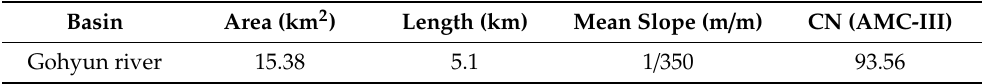
Table 1. Curve number (CN) value calculated in this study.